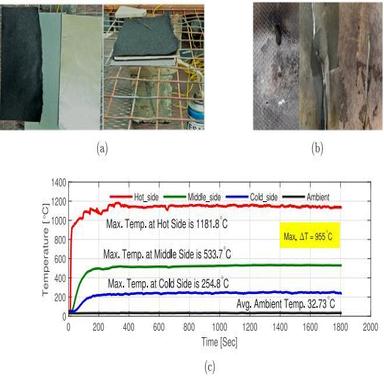
M12 — Fibreglass sheet (1 mm) + Mica laminate with wool (6 mm) + Graphite sheet (1.75 mm) (a) Before test, (b) After test, (c) Temperature plot.